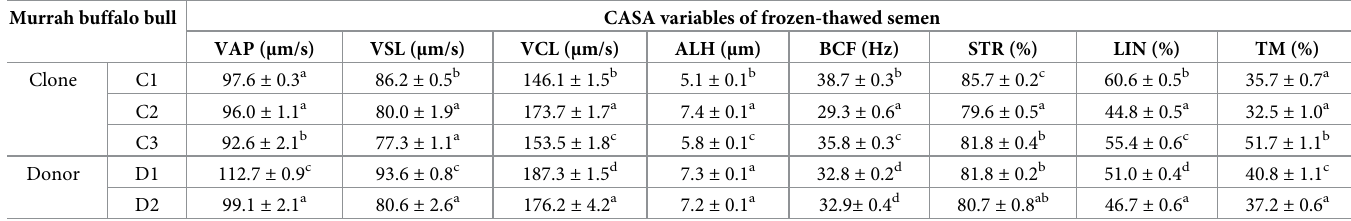
Table 2. CASA indices in frozen-thawed semen of cloned bulls and donors. Murrah buffalo bull CASA variables of frozen-thawed semen